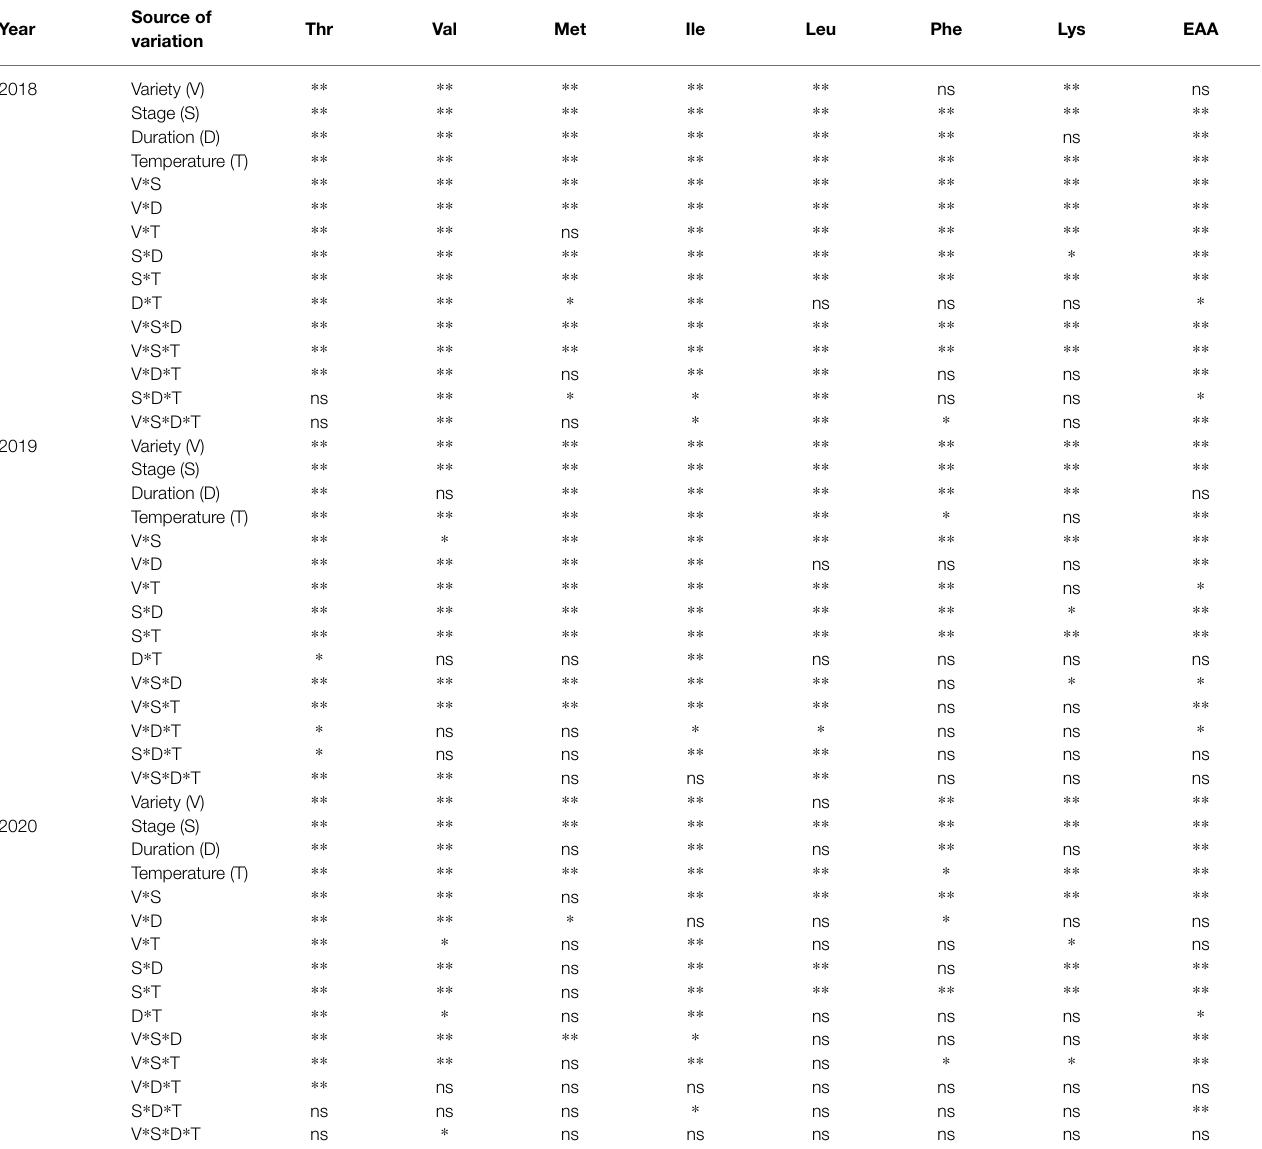
TABLE 2 | ANOVA results for the content of essential amino acids under low-temperature treatments. Source of Year